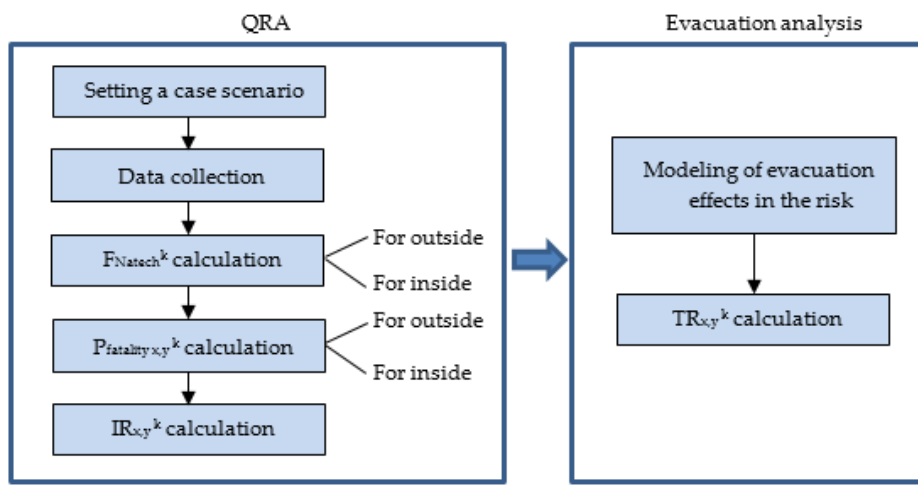
Figure 2. Framework for area-wide QRA (modified from Suda [12]).